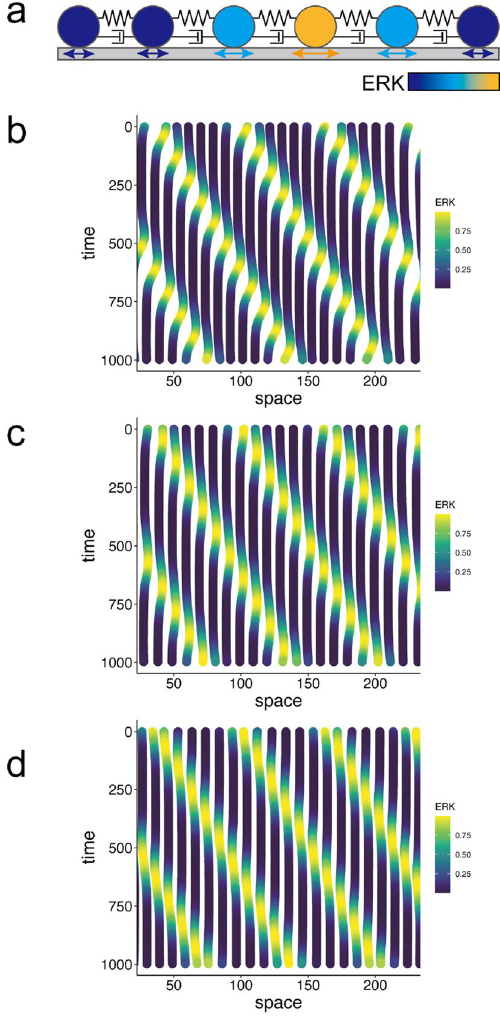
Figure 2. Simulations of the particle-based model in 1D ( a ). Graphical representation of the particle-based model. The centers of cells are illustrated by particles, and these are connected with neighboring cells by springs and dampers representing the elasticity and viscosity of the cytoplasm, respectively. ( b – d ). Simulations of ERK-induced collective cell migration with different parameter settings. Each line indicates cellular trajectory with the line color representing ERK activity. Parameters in Table 1 were used. In ( b ), cells migrate toward the opposite direction of the ERK waves. In ( c ), cells show back-and-forth movement during the ERK waves without net displacement. In ( d ), cells migrate toward the same direction of the ERK